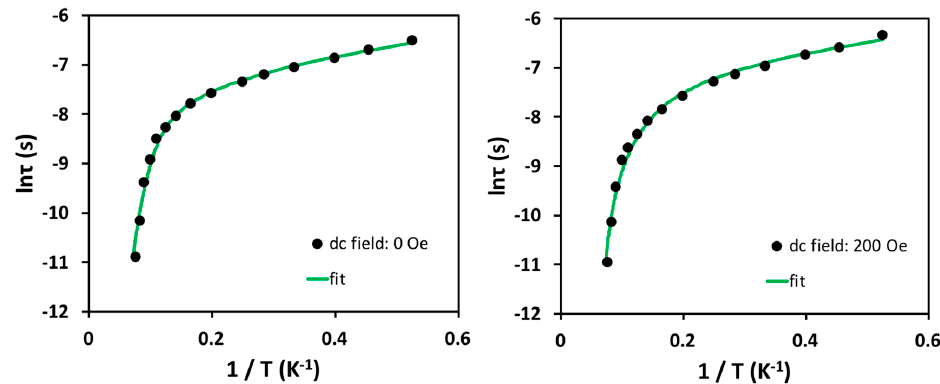
Figure 7. Arrhenius plots of 1 · 3MeOH · CH 2 Cl 2 at zero ( left ) and 200 Oe ( right ) applied dc fields. The green lines correspond to the fit of the data; see the text for the fit parameters.